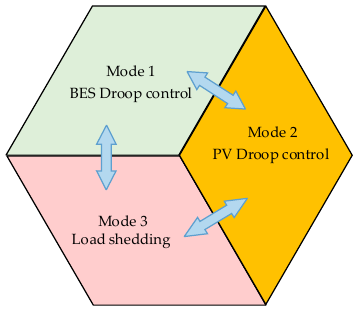
Figure 2. Multi-mode of DC microgrid.